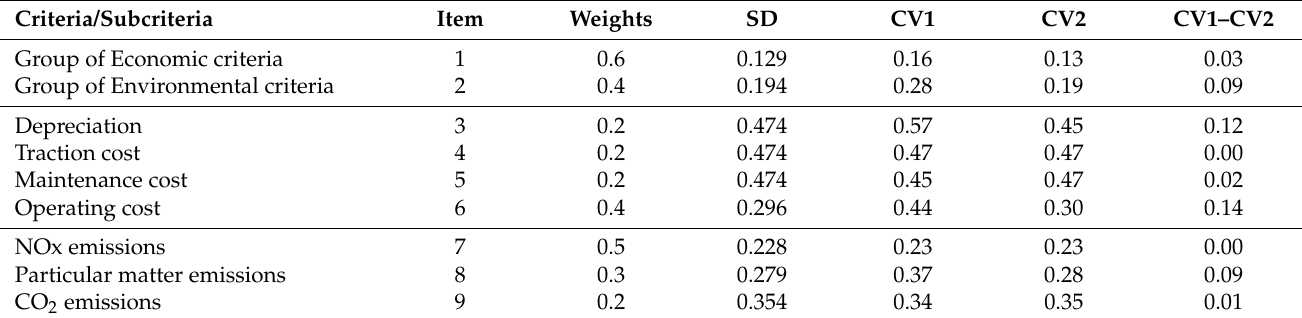
Table 13. Delphi model: consensus on elements, weights, and statistical data.